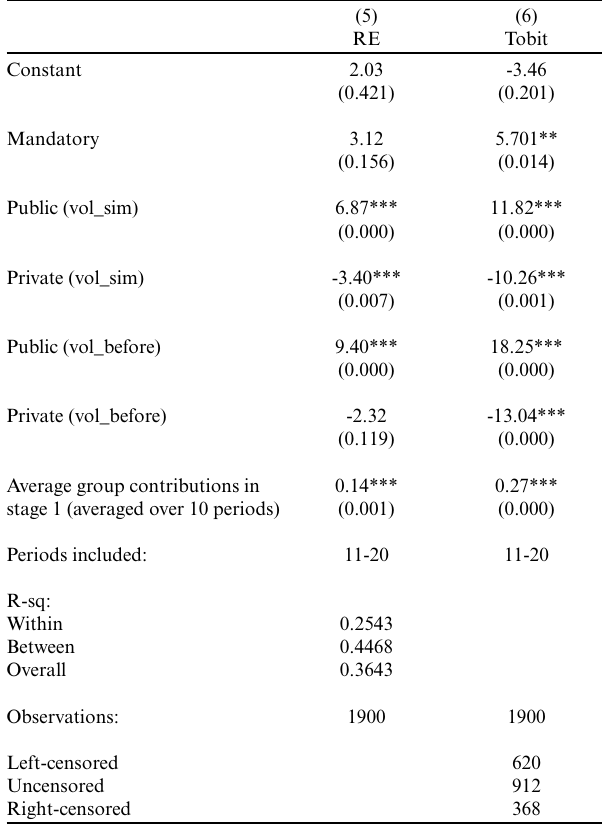
Table 3 . Panel logit regression on the decision to reveal contributions.